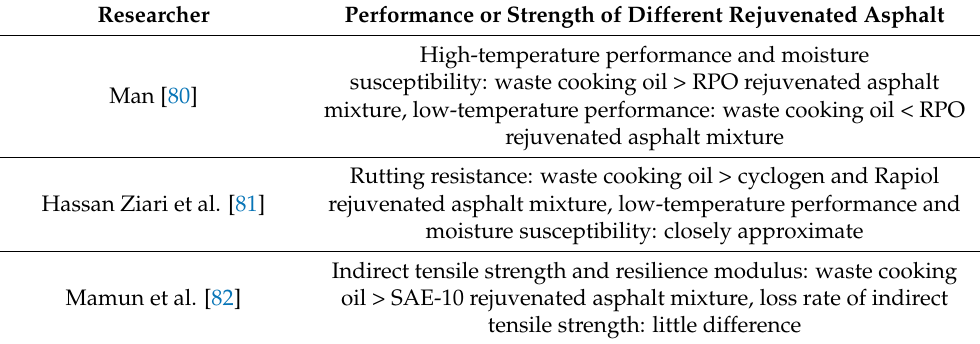
Table 16. Performance and strength of different rejuvenated